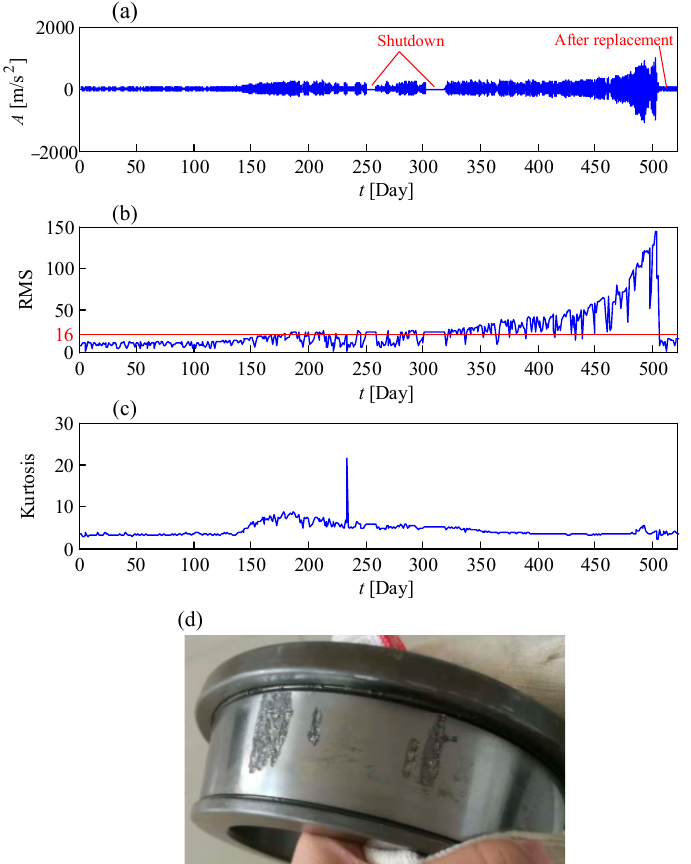
Figure 30. A life cycle vibration case from faulty rear bearing on the high-speed shaft of wind turbine gearbox: ( a ) temporal signal; ( b ) RMS; ( c ) kurtosis; ( d ) defective inner race of the